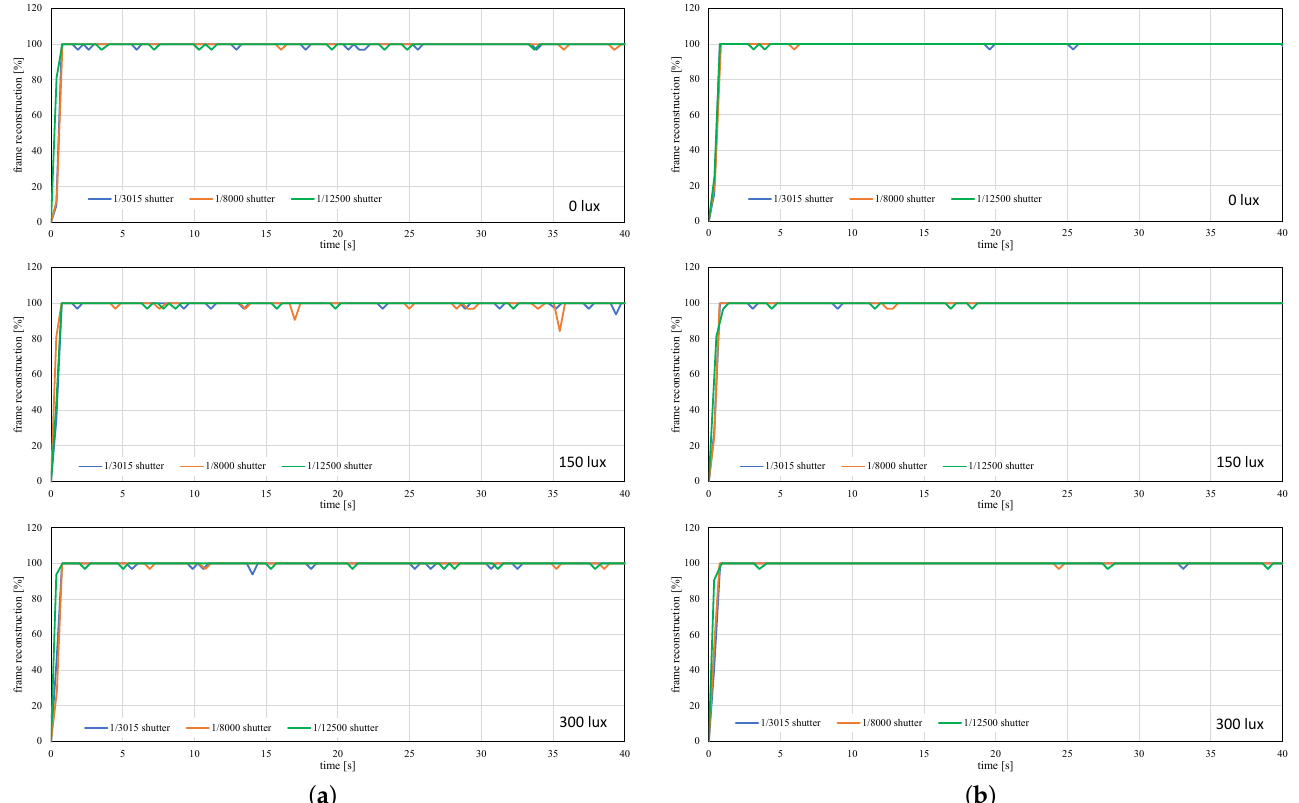
Figure 28. ( a ) Frame reconstruction ratio from HFR projector 1 and ( b ) frame reconstruction ratio from HFR projector